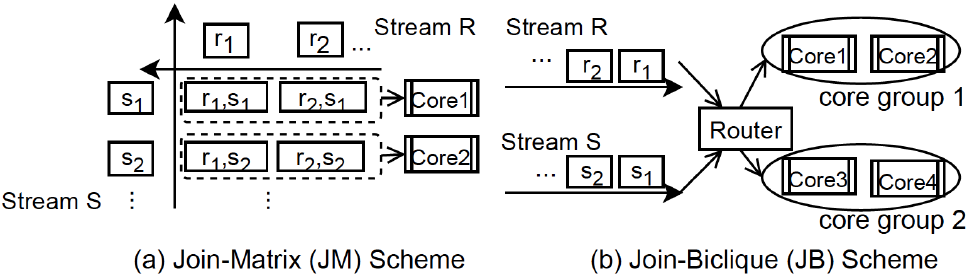
Figure 4. Join execution order under the Join-Matrix